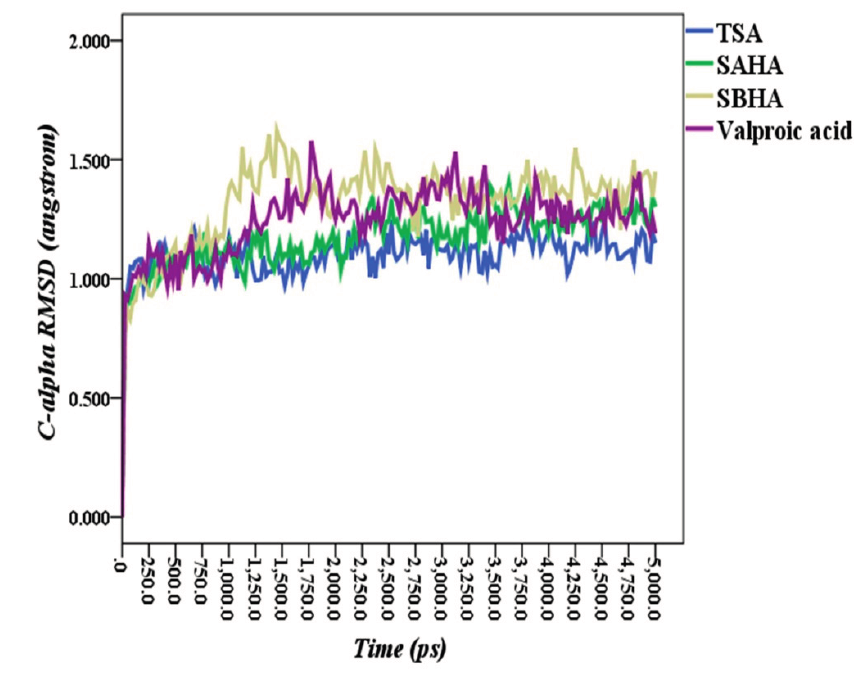
Figure 8. Root-mean-square deviation (RMSD) of C α atoms of enzyme-ligand complexes versus